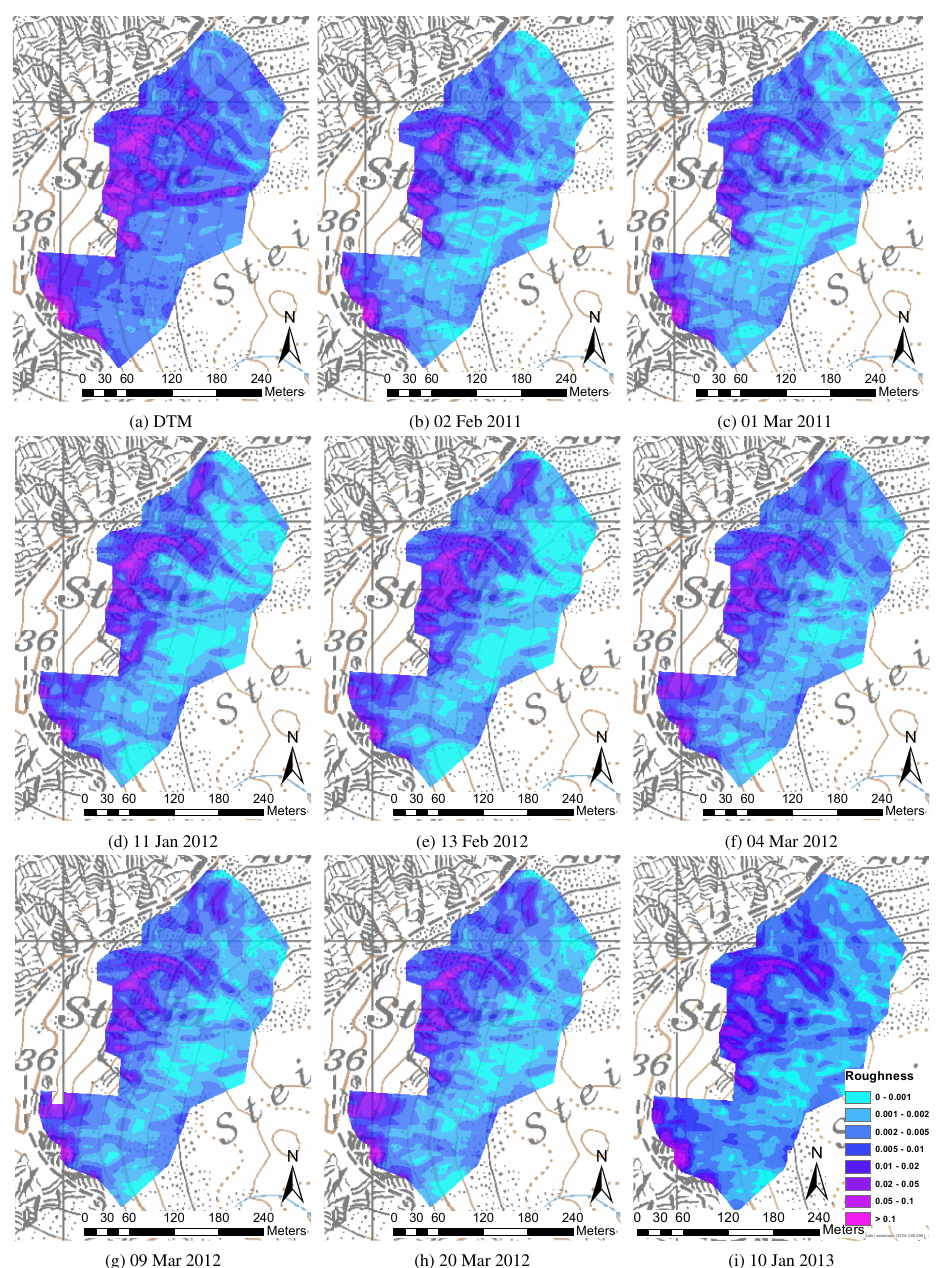
Fig. A2. Surface roughness of summer terrain and winter terrain at a scale of 15m in the basin ST. Pixmaps © 2013 swisstopo (5704 000 000).